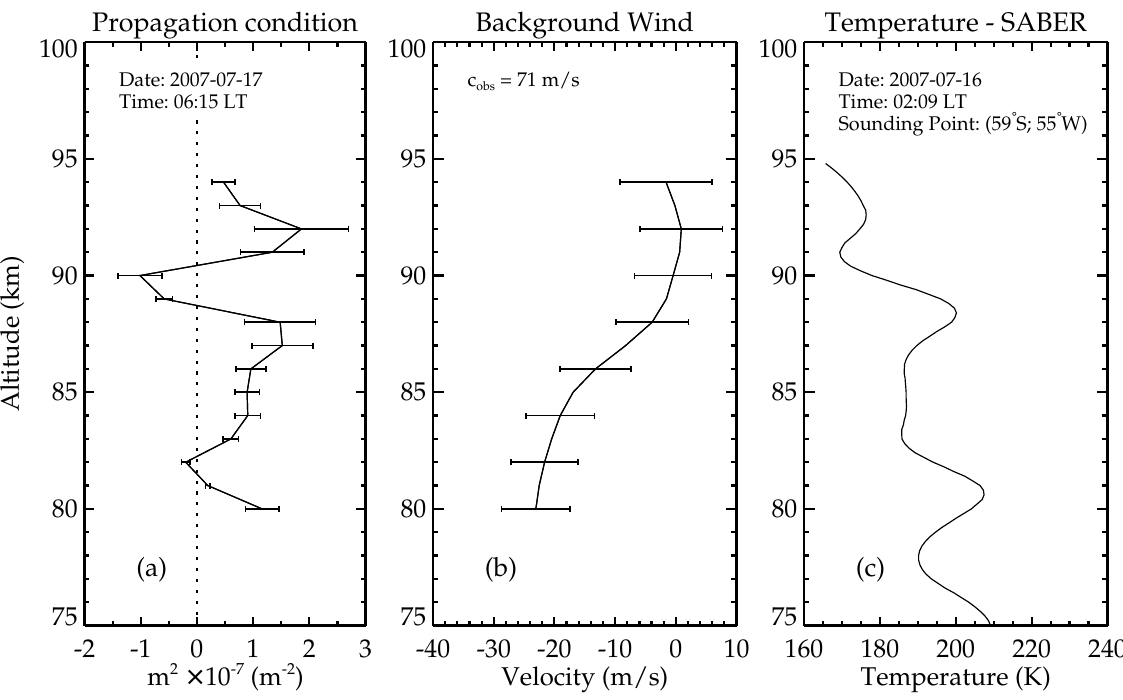
Fig. 4. (a) Vertical squared wavenumber (m 2 ), showing a duct region between ∼ 82 and ∼ 89km. (b) Hourly wind profile observed by MF radar, between 06:00 and 07:00LT, in the same propagation direction as the wave front. (c) Kinetic temperature profile obtained by SABER on 16 July